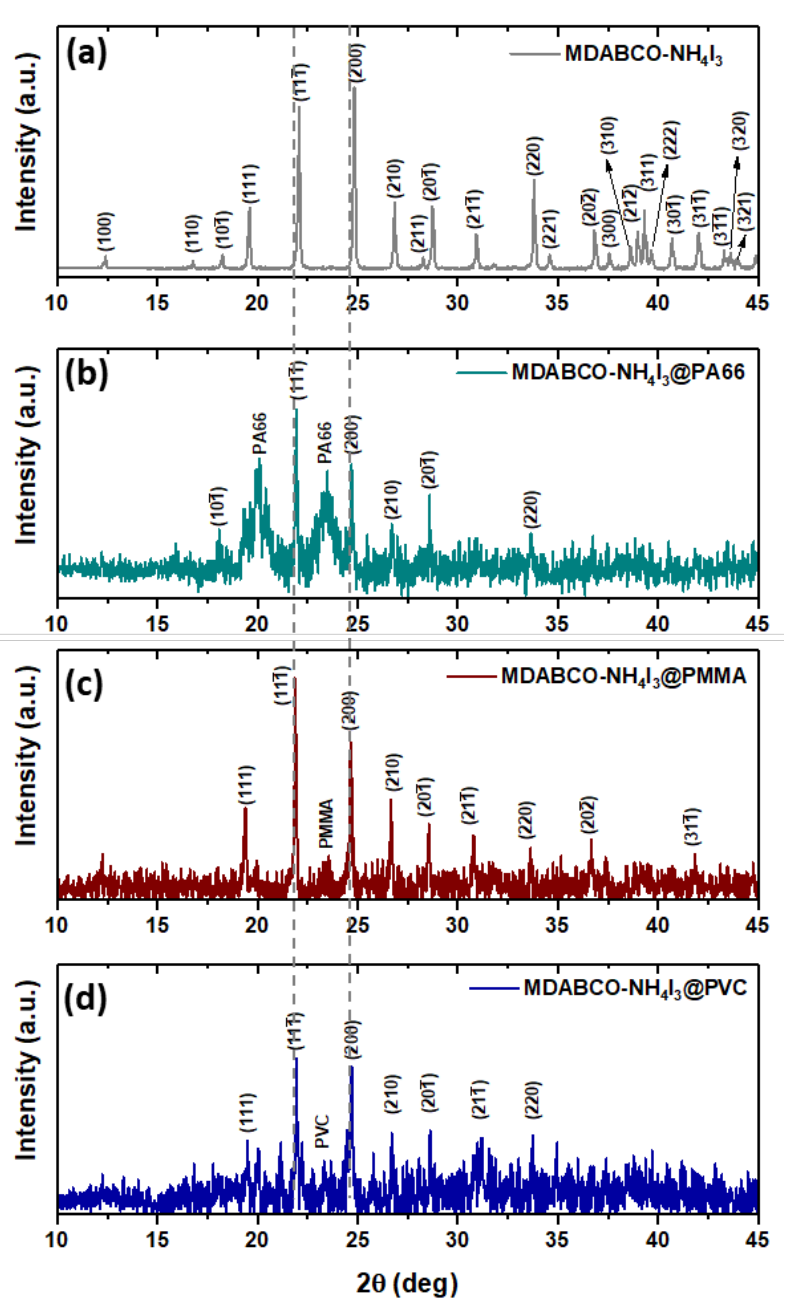
Figure 6. ( a ) Synthesized perovskite crystals with all Bragg peaks indexed from the published CIF file 1,836,322 [17]. X-ray patterns of PA66 ( b ), PMMA ( c ) , and PVC ( d ) nanofibers with embedded MDABCO-NH 4 I 3 perovskite crystals between 10° and 45°.